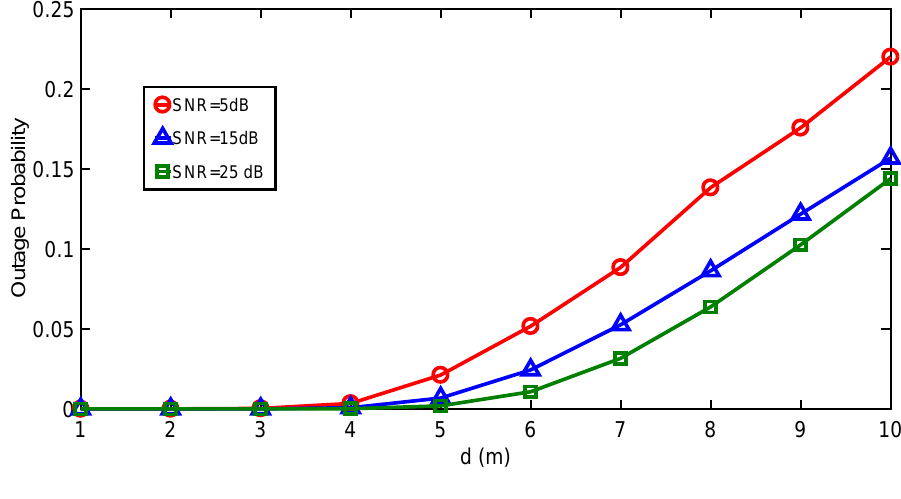
Figure 3. Impact of d on outage probability.